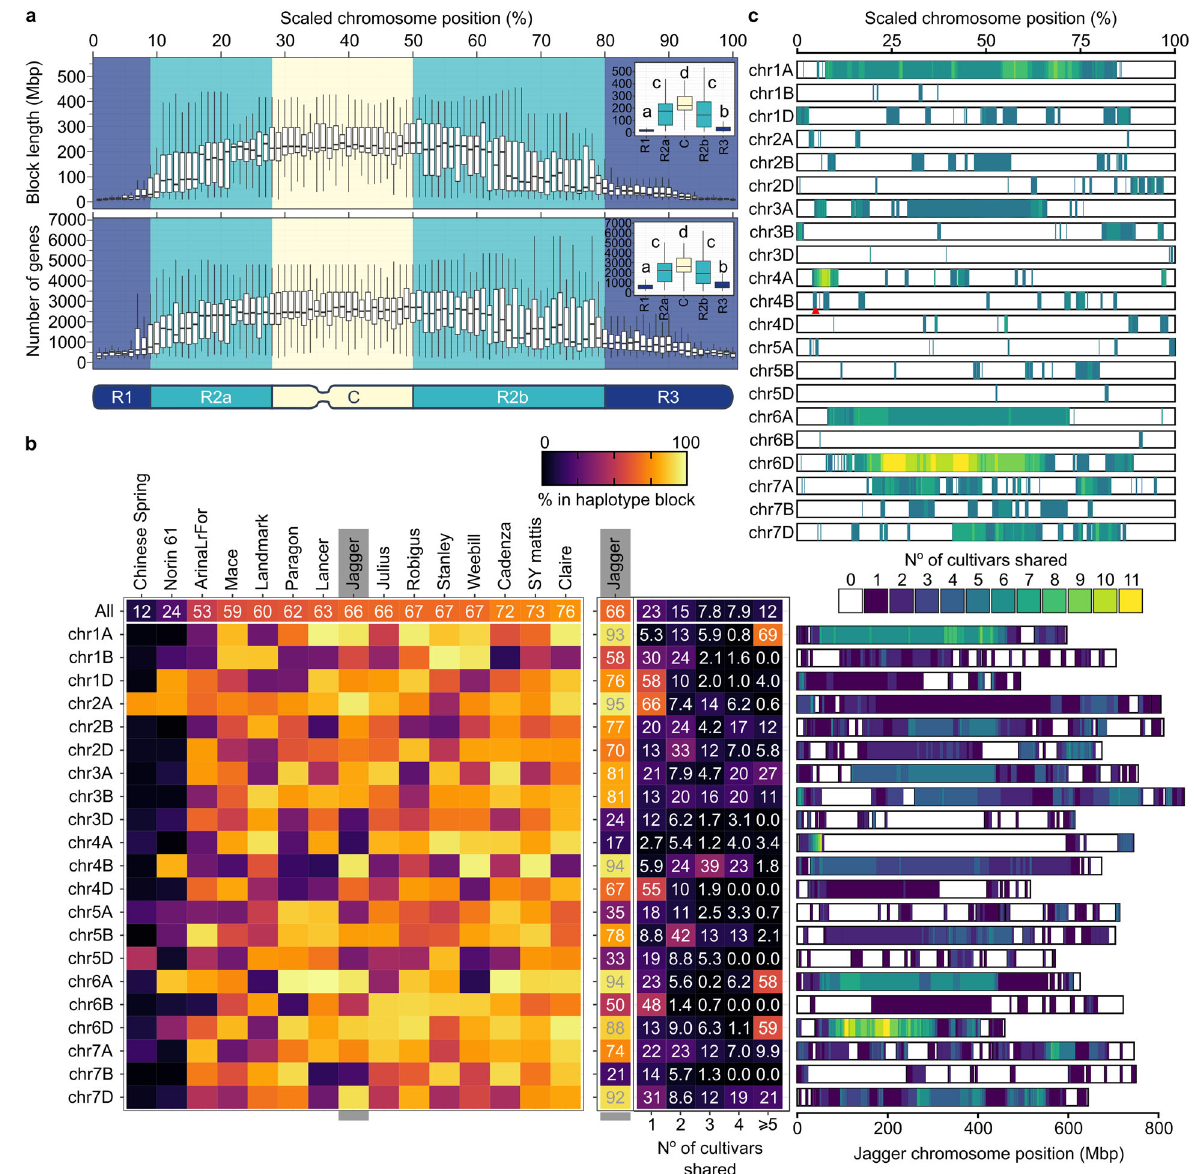
Fig. 2 Genome-wide characterisation of haplotype blocks. a Length (upper) and gene number (middle) of haplotype blocks sampled at 500 Kbp intervals across all 21 chromosomes (positions scaled to % of maximum chromosome length). Boxplots show distributions of 1% bins. Insets show boxplots for chromosomal compartments (bottom) based on recombination (R1 + R3 > R2a + R2b > C) 15 . Pairwise Wilcox test with Benjamini – Hochberg multiple testing correction was used for statistical analysis. b Leftmost heatmap shows % of the genome (top row) or chromosomes contained within haplotype blocks for all cultivars. Jagger values are highlighted (middle), with a breakdown of how many other cultivars share these Jagger haplotype blocks. Rightmost panel shows the physical positions of Jagger haplotype blocks. c Summary of highly conserved haplotype blocks across all cultivars (shared with ≥ 5 cultivars; positions scaled to % of maximum chromosome length per cultivar). Values based on haplotype blocks called using 5-Mbp bins. RHT-B1 is indicated by a red